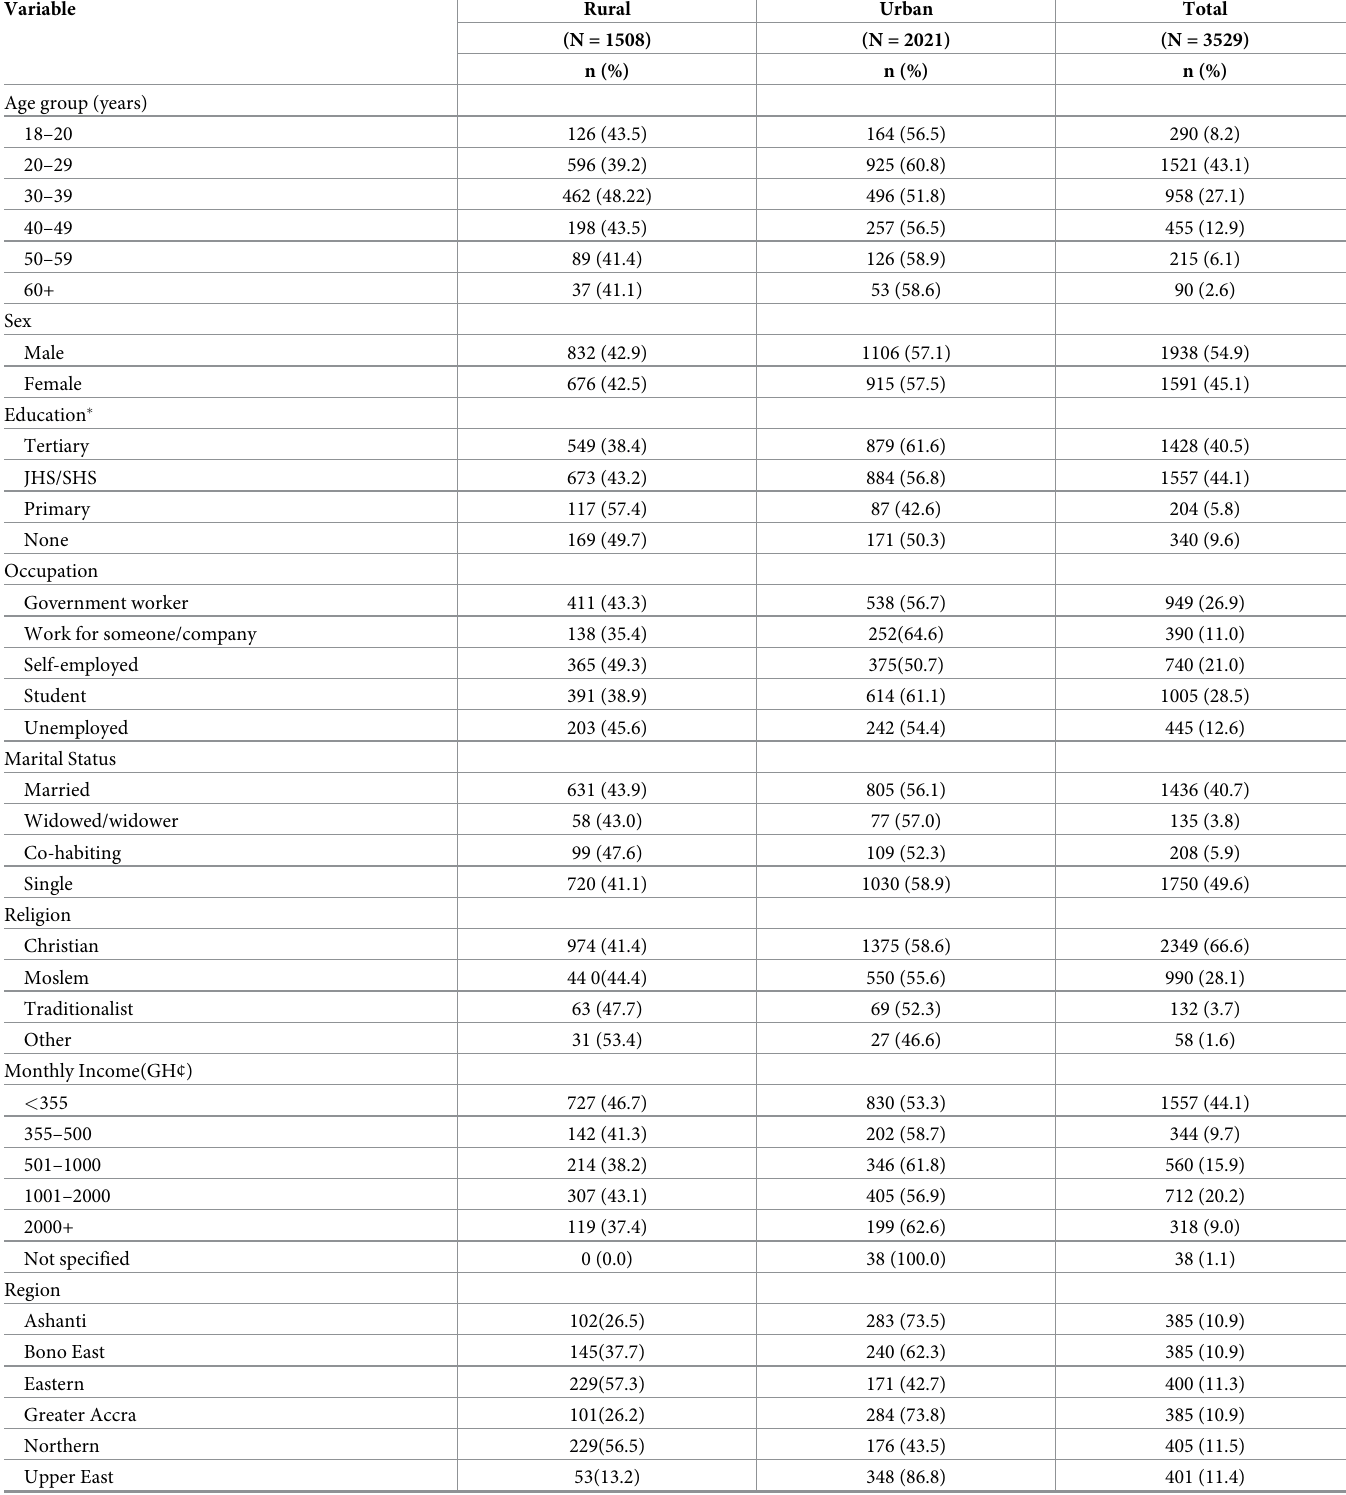
Table 1. Socio-demographic characteristics of